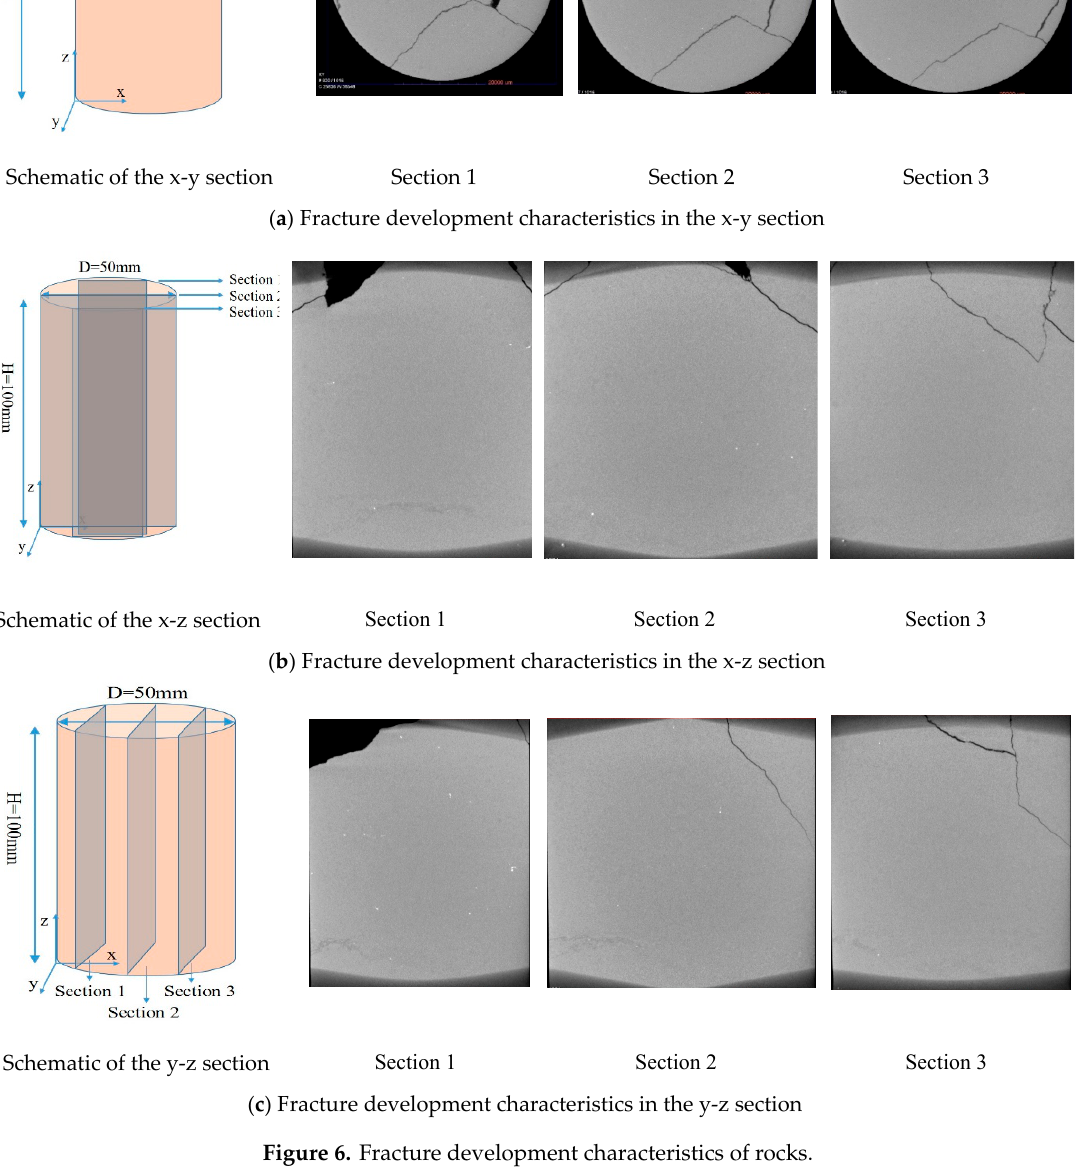
Figure 6. Fracture development characteristics of rocks.